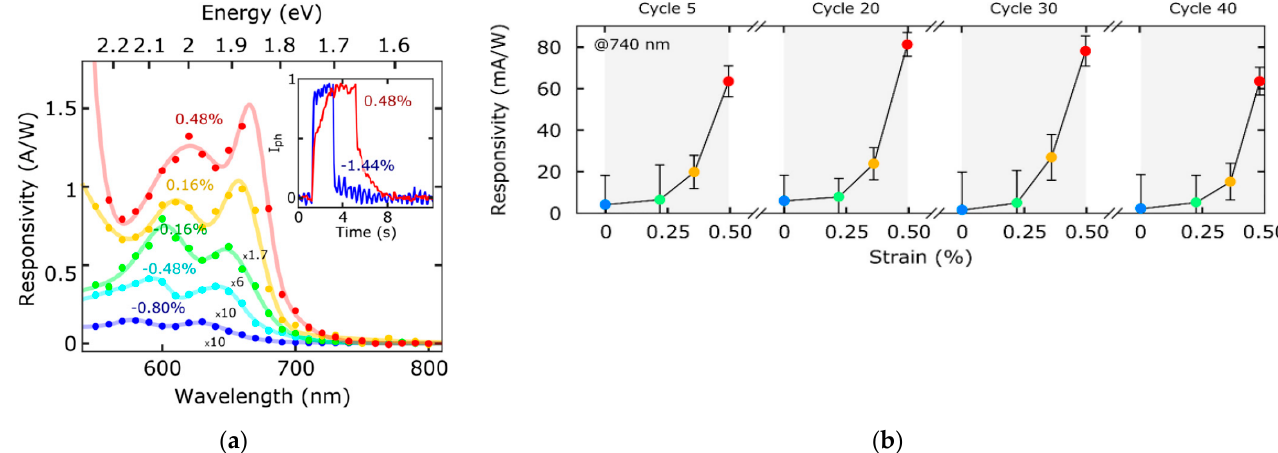
Figure 9. ( a ) Responsivity values over the spectral range for a ZnS-MoS2-based device when it is subject to various strains. In the inset the temporal response for different strain applications is shown. ( b ) Responsivity values against the applied strain increasing the bending cycle number. Reprinted with permission from ref. [26]. © 2019, Elsevier.